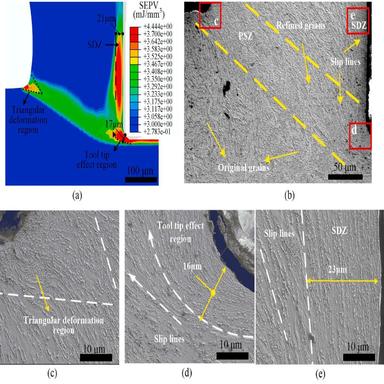
Simulation results of SEPV field and experimental slip line distribution in the cutting deformation zones at 150 m/min. (a) Simulation result of SEPV field. (b) SEM image of slip line distribution. (c)–(e) The enlarged SEM images corresponding to the triangular deformation region (area c), tool tip effect region (area d) and SDZ (area e) in (b), in which the white lines represent the slip lines.